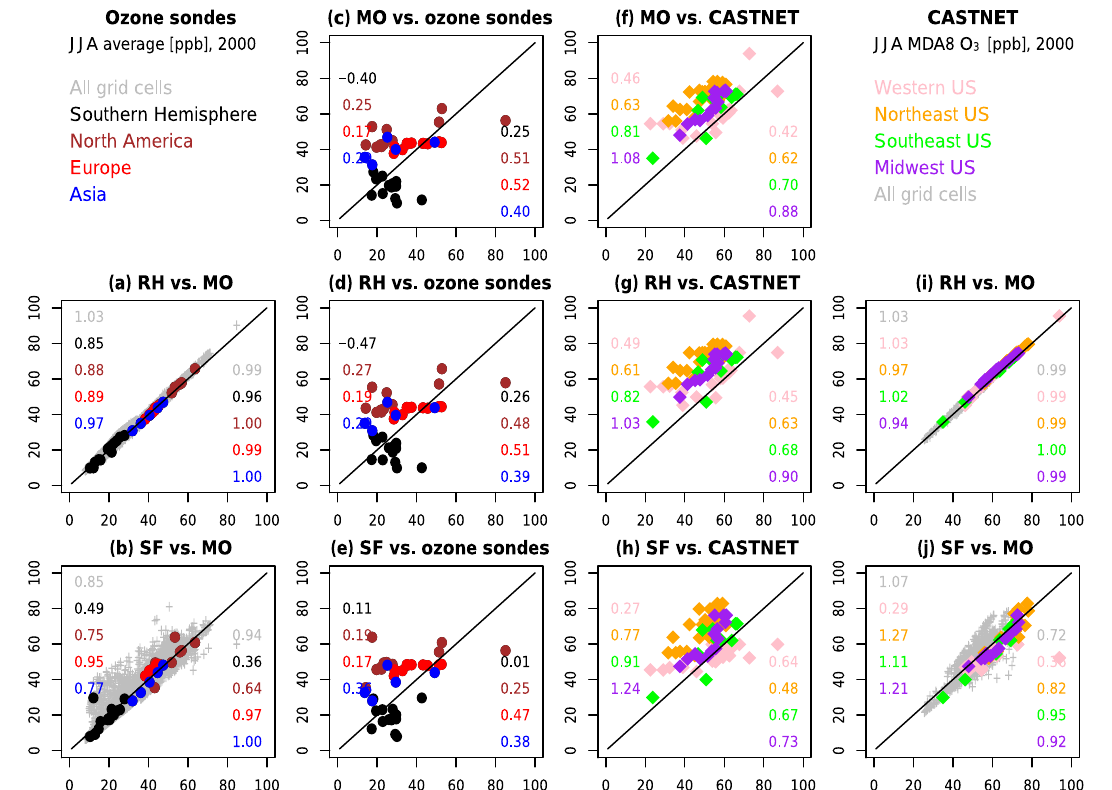
Figure 10. Scatterplots comparing model results to observations (two center columns) and to each other (two outer columns). Global com- parisons to observations (c, d, e) compare model results to ozonesondes (JJA averages), while regional comparisons to observations (f, g, h) compare the model results to CASTNET surface observations (JJA MDA8 O 3 ). For the model-to-model comparisons (global in a, b and within the US in i, j ), grey symbols additionally compare every grid cell in the model output. The numbers within each subplot indicate the slope (left hand side) and R 2 values (right hand side) for each region. Each panel is labeled with the following convention: “ y axis” vs. “ x